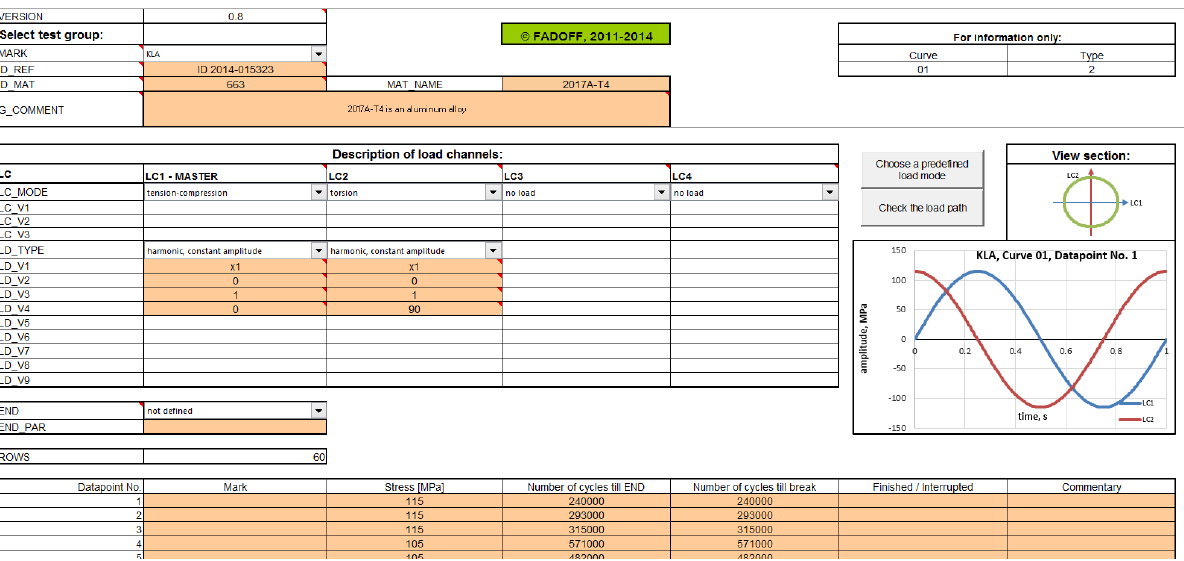
Figure 1. "Form" sheet of FinLiv with sample data.